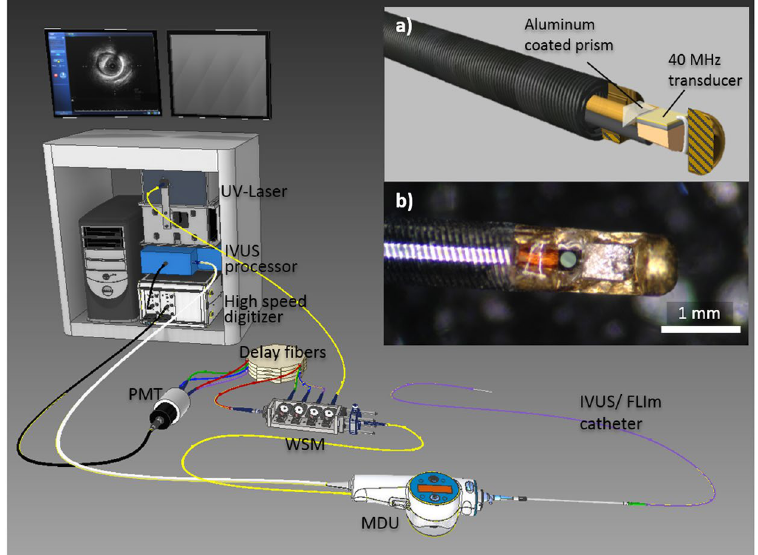
Figure 1. System overview. The system, able to display IVUS images in real time using the clinical interface, is composed of a 3.7 Fr IVUS/FLIm catheter, an IVUS motor drive unit (MDU) modified to accommodate an optical channel, connected to a wavelength selection module (WSM). The WSM enables both coupling of the pulsed excitation light and spectral decomposition of the collected fluorescence signal. The signal from each band is sent to the photomultiplier tube (PMT) using different lengths of optical delay lines that enables measurement over four wavebands using a single detector. When acquiring bimodal data, co-registration is insured by sampling both FLIm and IVUS signal with a single